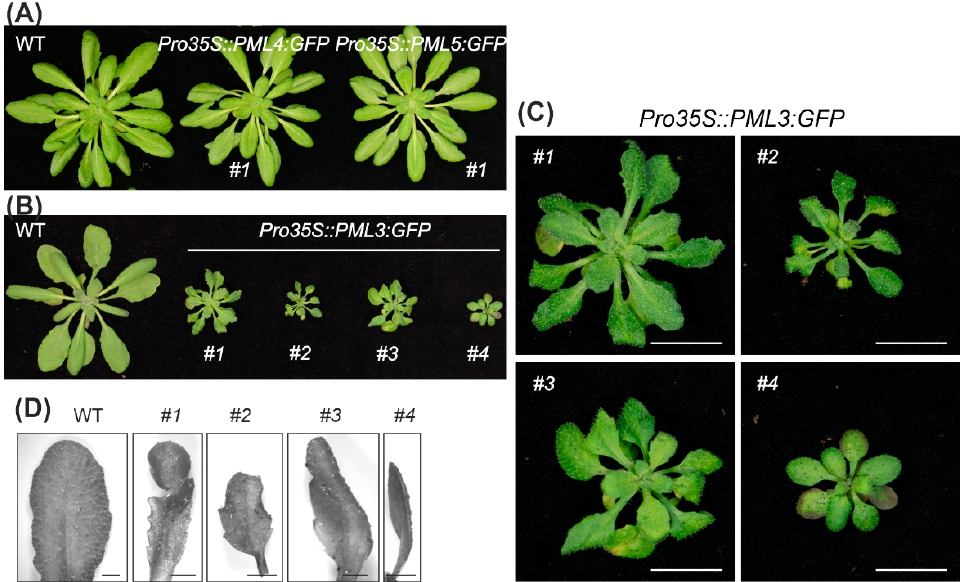
Figure 3. Photographs of stably transformed Arabidopsis lines. ( A ) Pro35S::PML4:GFP and Pro35S::PML5:GFP plants in comparison to a wild-type plant are shown. ( B ) WT and transgenic lines Pro35S::PML3:GFP #1, #2, #3, #4 were grown for 3 weeks under a 12 h/12 h light–dark cycle and 2 weeks in the greenhouse. ( C ) Magnified images of plants shown in (B), Scale bar = 1 cm. ( D ) Magnified images of individual leaves taken from the plants shown in (B) and (C), Scale bar = 2 mm.